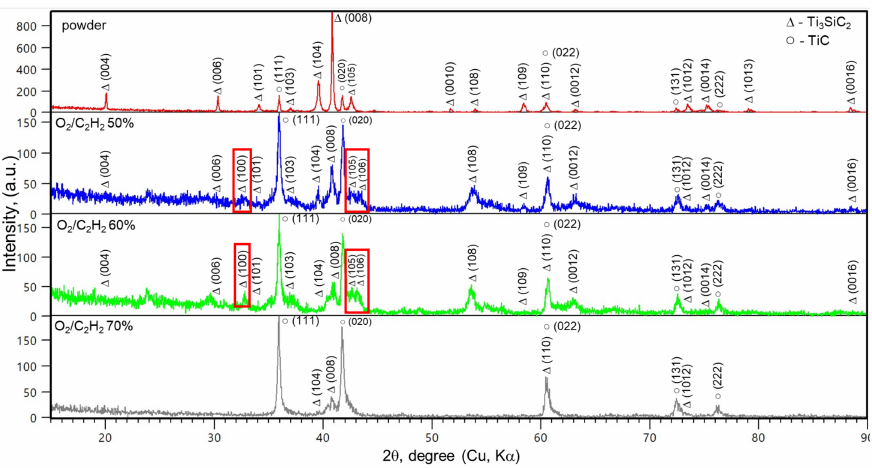
Figure 3. Diffractogram of Ti 3 SiC 2 powder and Ti–Si–C coatings obtained at different filling volumes of the explosive gas mixture of the detonation gun